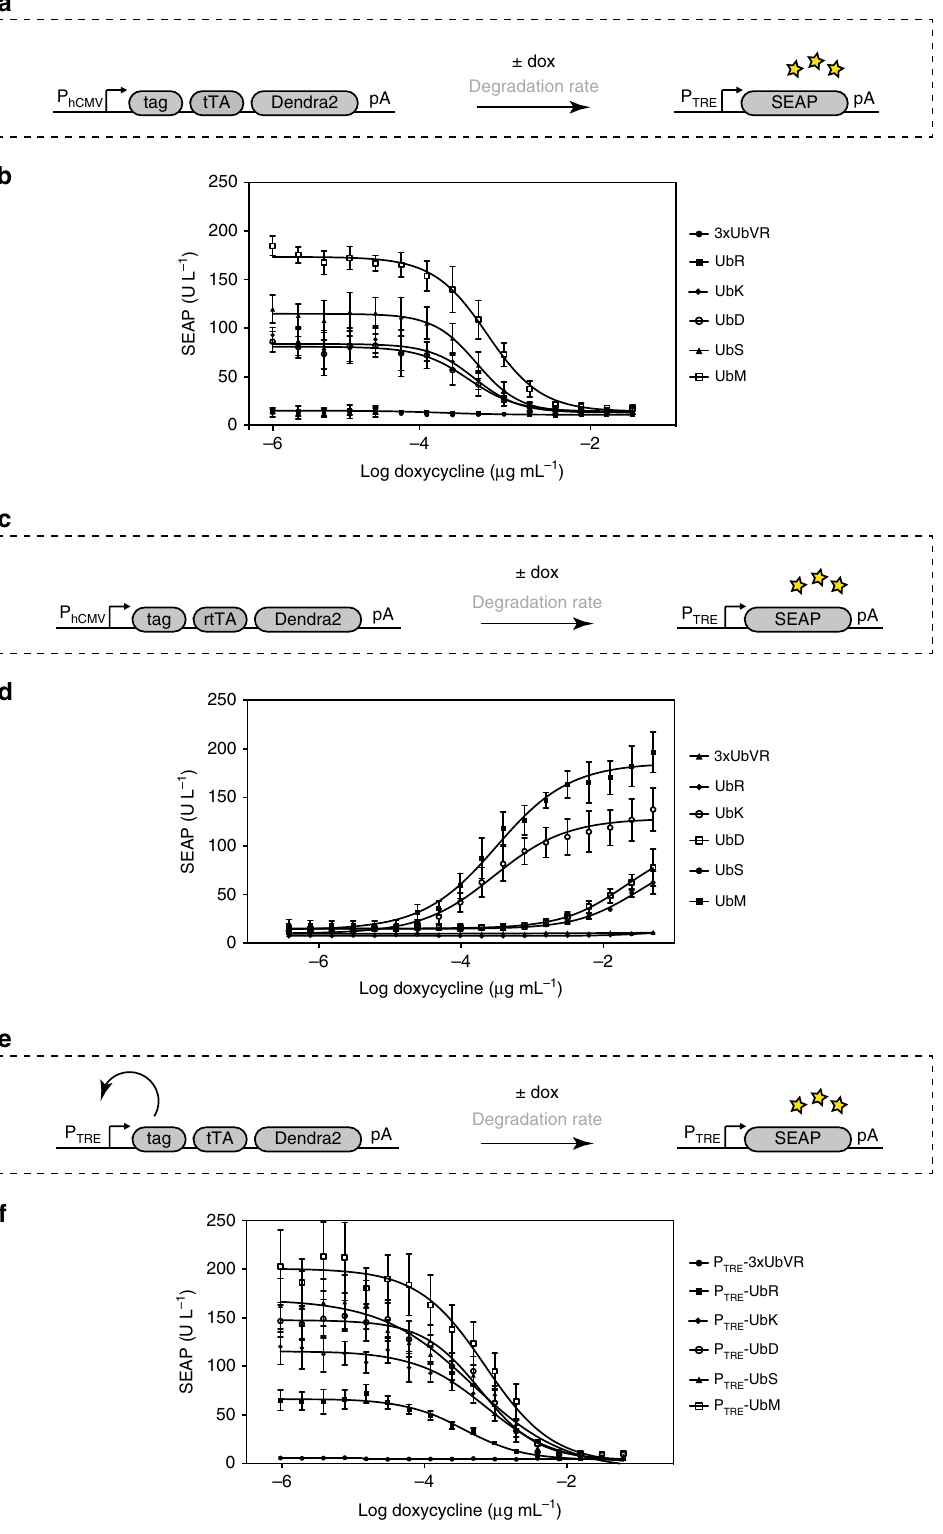
Supplementary Fig. 9a, b, Supplementary Movies 1 and 2). By applying the half-life-modulating tags to the negative-feedback element P TtgR1 -tag- L7Ae -P2A- Citrine -pA of the pulse generator, we could establish a set of expression pulses with mean